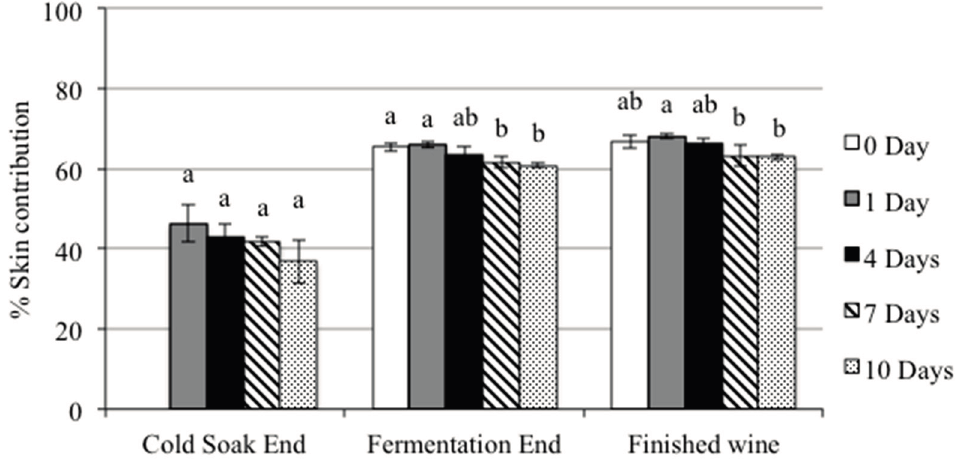
Figure 4. The percentage of skin tannin contribution with different CS durations at the end of CS, the end of fermentation and in finished wines. Means with different letters are significantly different ( p < 0.05, n =